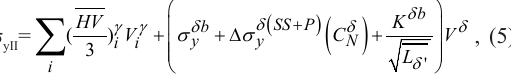
Figure 7. The ultimate tensile strength (σ (σ ) ratios at different cooling times corresponding to the HAZs y0.2 of the UNS S31803 and UNS S 32304 DSSs.